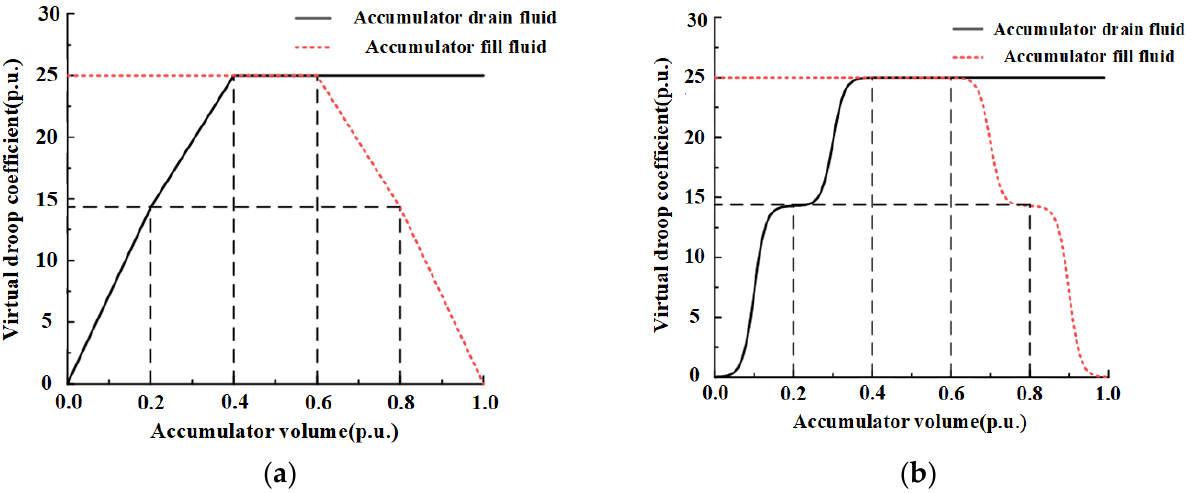
Figure 10. The accumulator virtual droop coefficient before and after optimization. ( a ) Initial virtual droop coefficient of the accumulator. ( b ) Optimized virtual droop coefficient of the accumulator. Combined with the sigmoid growth curve, the curve changing with the effective volume of the accumulator can be regarded as an “ S ” curve, as shown in Figure